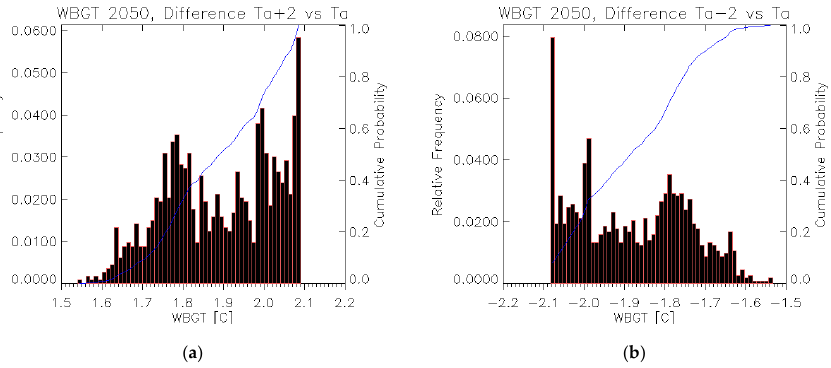
Figure A6. Relative and cumulative (blue line) distributions of the e ff ects of an uncertainty of ± 2 ◦ C in air surface temperature on maximum WBGT for February-March 2050. WBGT[C] ( x -axis) is the di ff erence (WBGT Ta + 2 –WBGT Ta ) assuming Ta to be CORDEX Ta + 2 ◦ C ( a ) and (WBGT Ta–2 –WBGT Ta ) assuming Ta to be CORDEX Ta − 2 ◦ C ( b ).